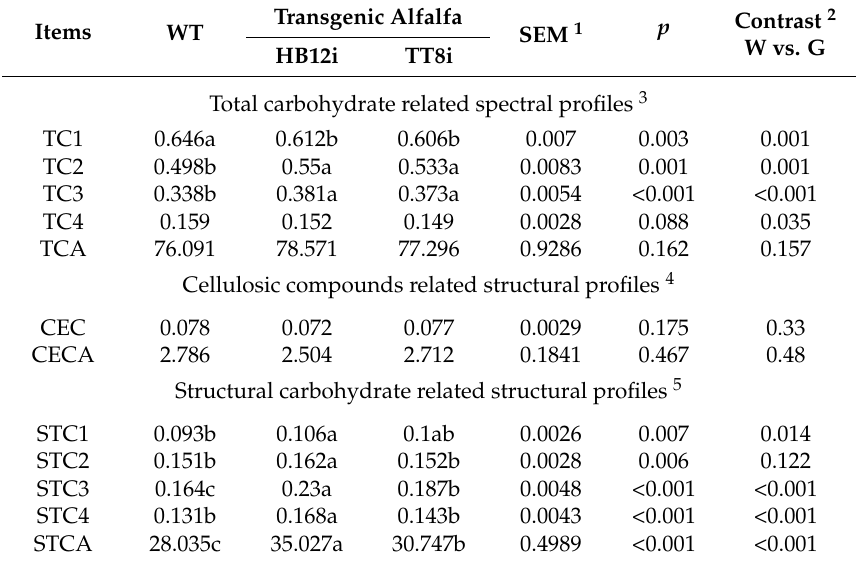
Table 1. Carbohydrate structural parameters of transgenic and wild type (WT) alfalfa. Transgenic Alfalfa Items WT SEM